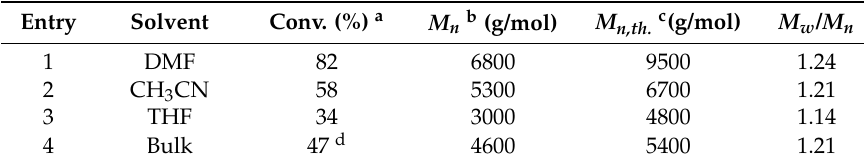
Table 1. The molecular characteristics of the mediated RAFT polymerization of PMAC 2 NP 2 in different solvents at 70 ◦